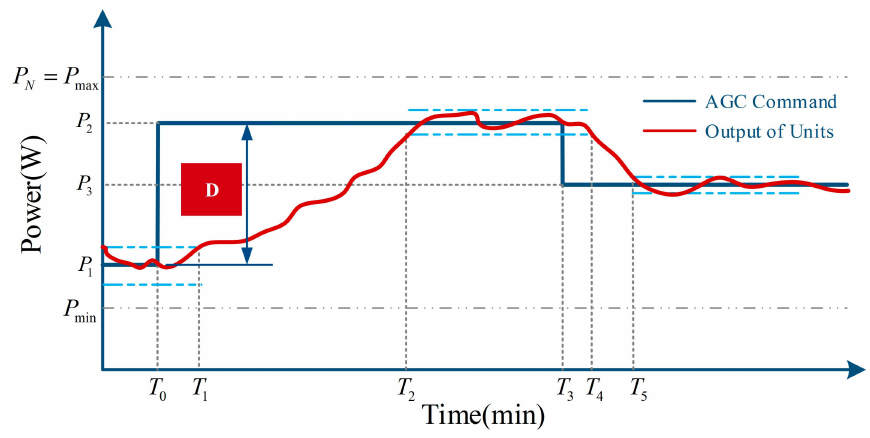
Figure 1. The setting point control process of automatic generation control (AGC)